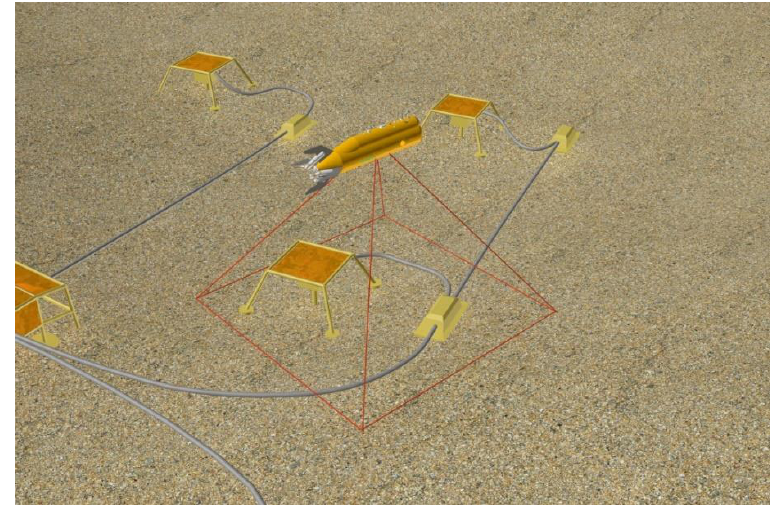
Figure 6. Virtual stage: AUV performs SPS inspection.